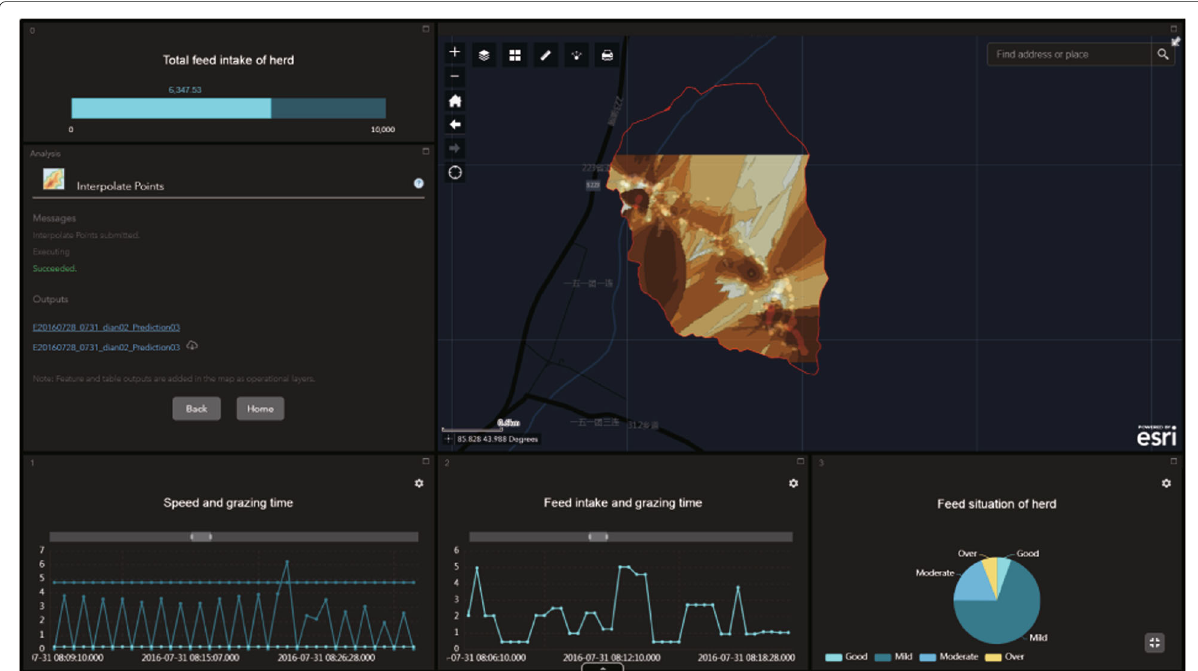
Fig. 11 The interpolation analysis result diagram of the